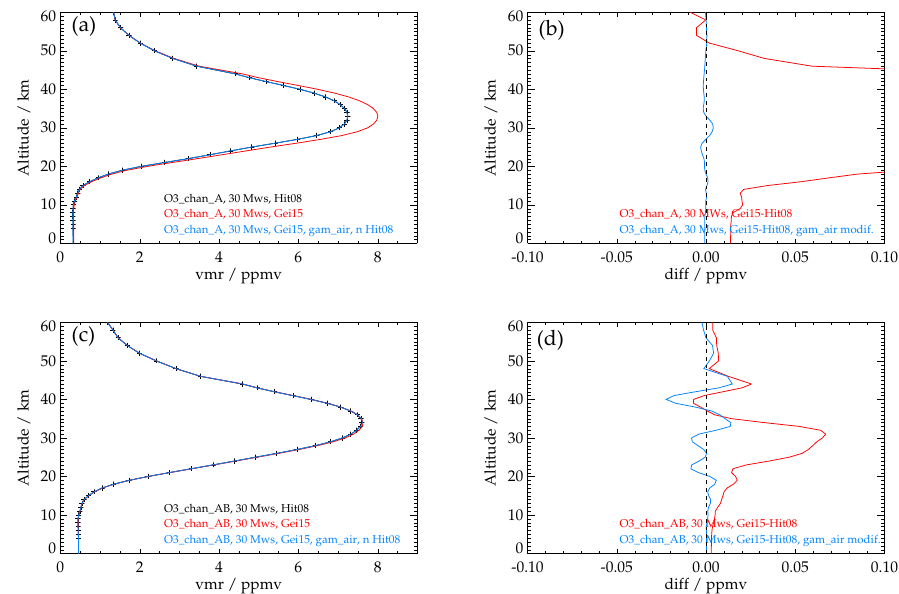
Figure 10. (a) Mean ozone profiles of 59 orbits from 3 January, 1 April, 2 July and 2–3 October 2009, retrieved in MIPAS channel A using the HITRAN-2008 (black), the GEISA-2015 (red) and a modified GEISA-2015 spectroscopy (blue). The modification consists of replacing the air-broadened half widths and coefficients of temperature dependence by the HITRAN-2008 values. (b) Corresponding differences to the ozone profile resulting from use of the HITRAN-2008 spectroscopy. (c) Same as (a) but for MIPAS channel AB. (d) Same as (b) but for MIPAS channel AB.